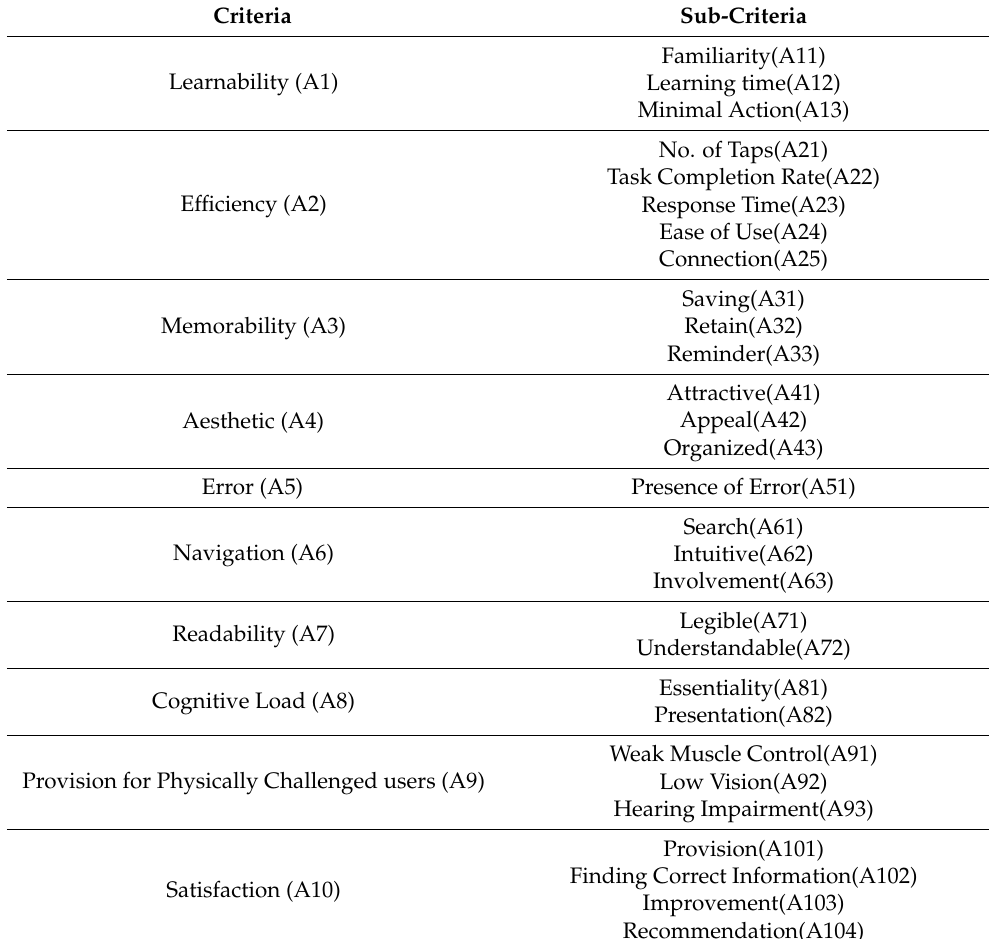
Table 1. Usability criteria and associated sub-criteria for assessing T2DM mHealth